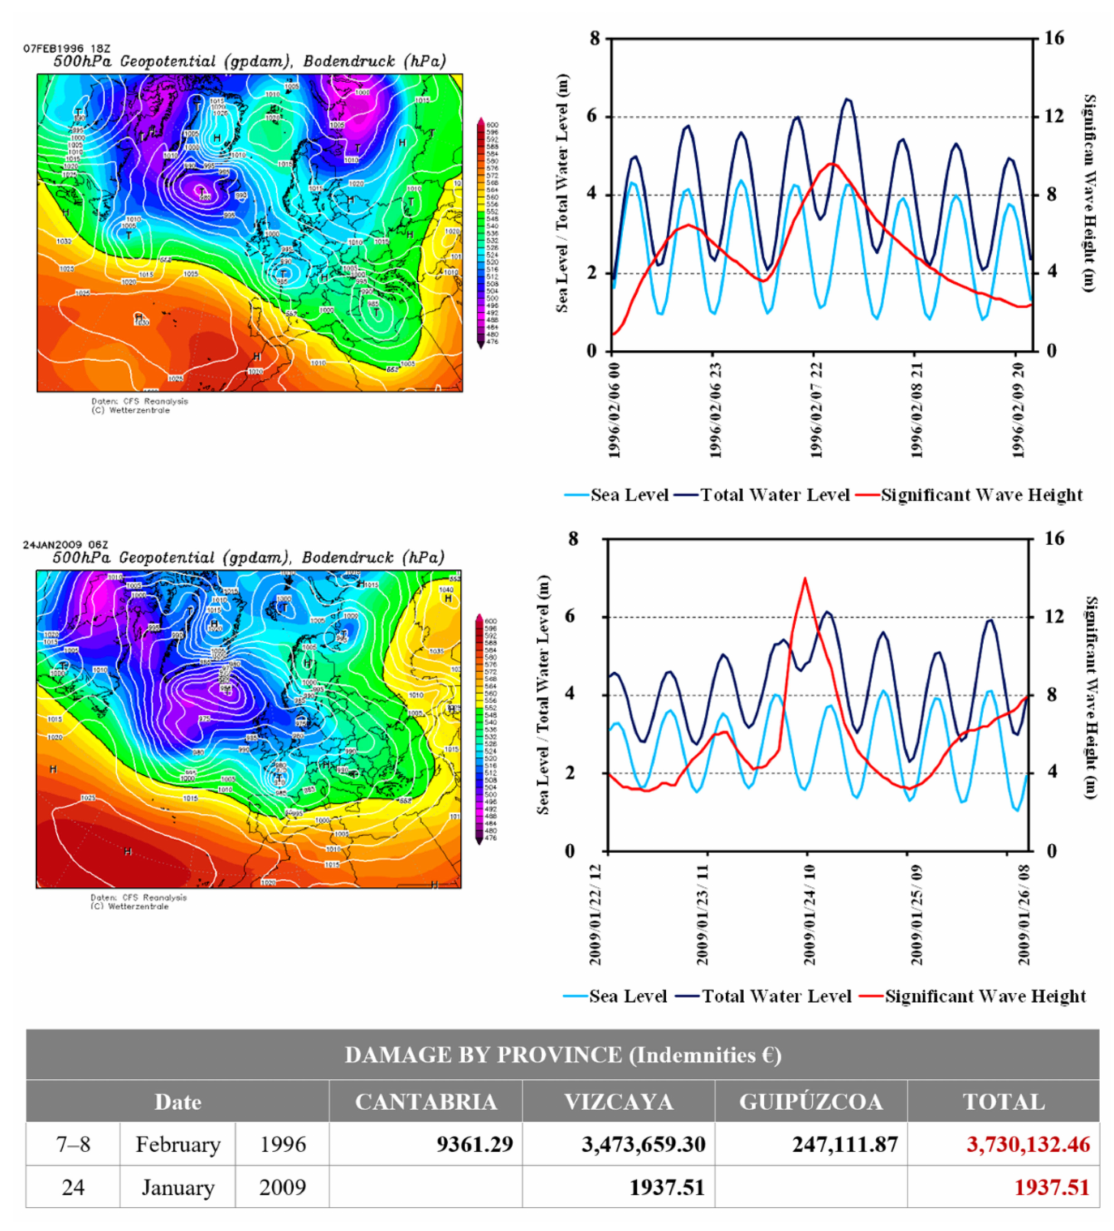
Figure 14. Weather charts (https://www.wetterzentrale.de/, accessed on 3 May 2022), oceanographic conditions, and amount of indemnities during two selected storms